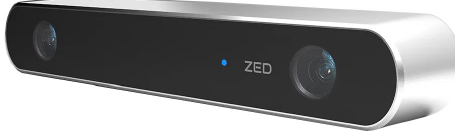
Figure 3. Stereo camera: